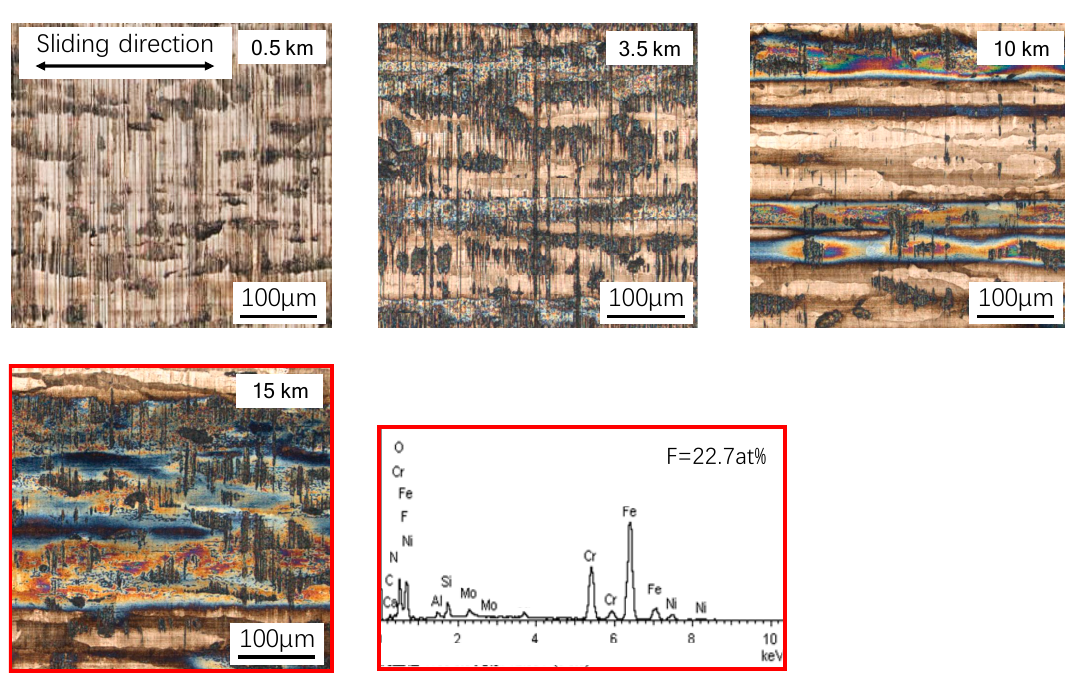
Figure 10. Typical CLSM images of the counter-part surface showing the transfer film development at 200 °C, and the chemical composition after 15 km sliding.